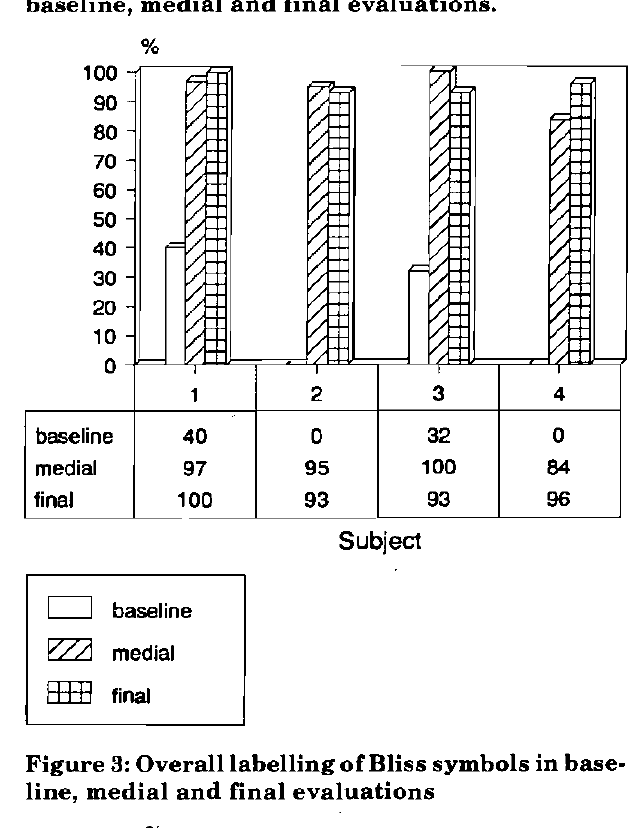
Figure 3: Overall labelling of Bliss symbols in base- line, medial and final